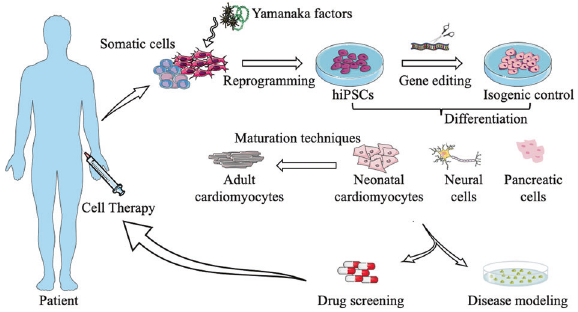
Fig. 3 Potential applications of patient-speci fi c induced pluripo- tent stem cells for patients harboring ryanopathies. Recapitulative scheme illustrating the potential use of hiPSC generated from a patient blood sample or somatic cells and carrying RyR2 mutation. Some isogenic control hiPSC could be generated by correcting the single-RyR2-point mutation using CRISPR/Cas9 technology. The hiPSC could then be differentiated into cardiomyocytes, neural and pancreatic cells. These generated cells could be used for disease modeling and drug screening approaches for a potential patient- speci fi c cell